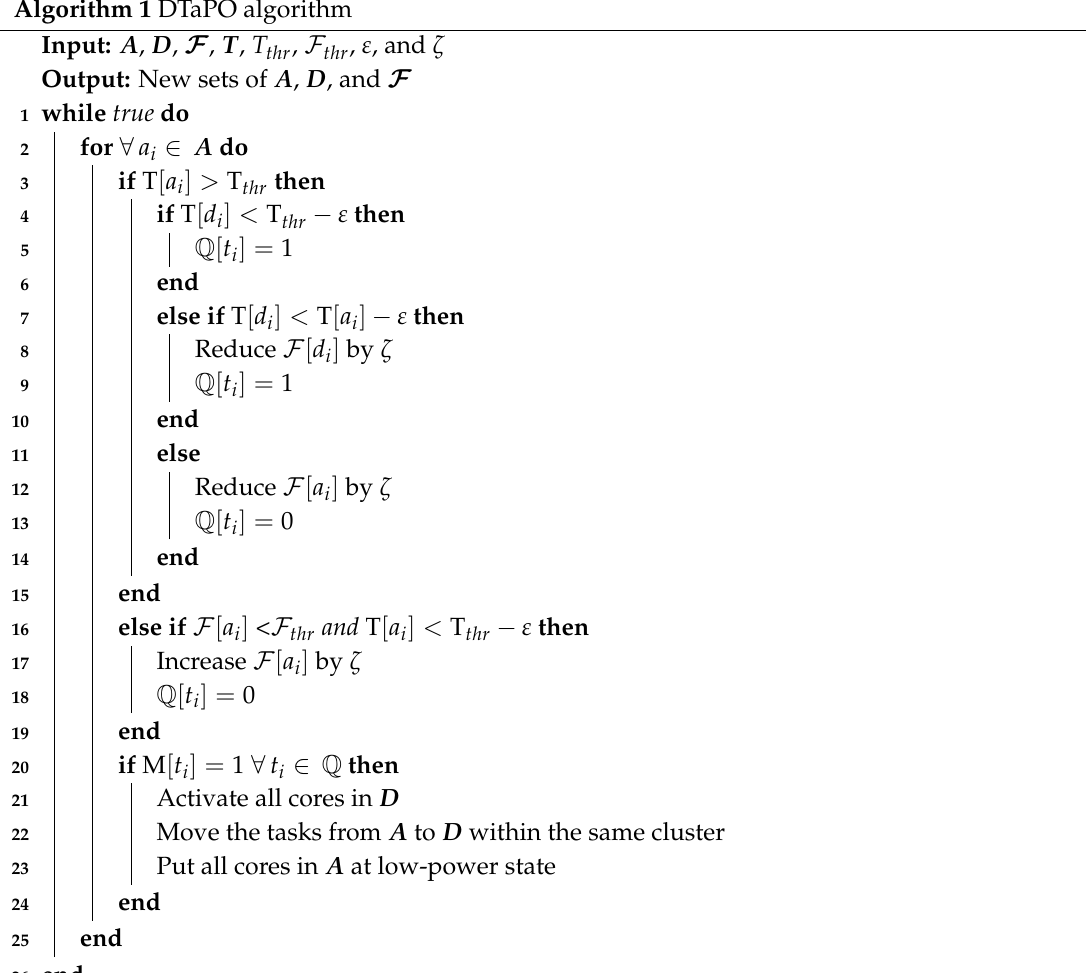
Algorithm 1 DTaPO